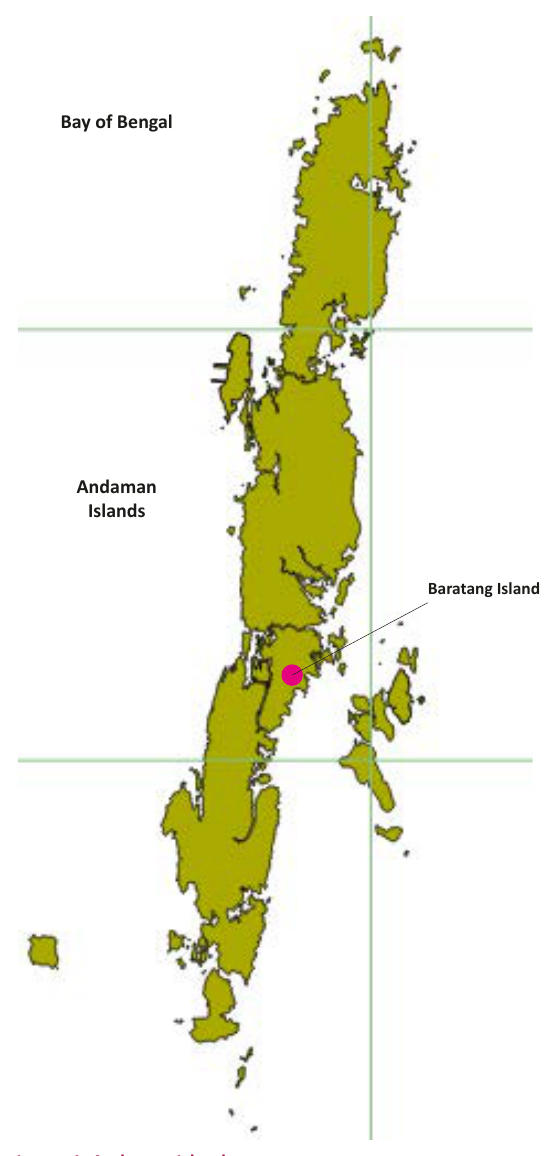
(Fig. 1) urn:lsid:indexfungorum.org:names: